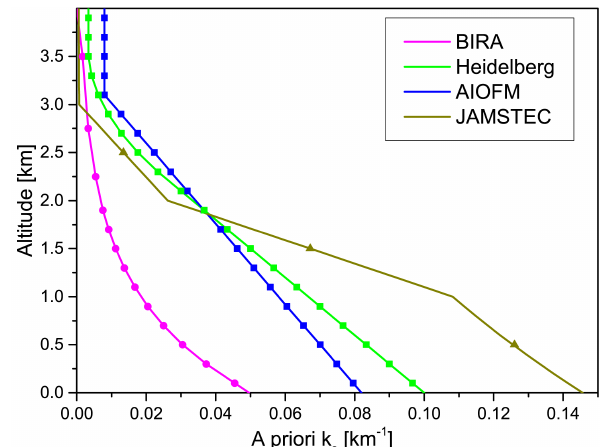
Figure 1. A priori profiles for the BIRA, Heidelberg, AIOFM, and JAMSTEC retrievals. The symbols indicate the centre of each re- trieval layer. The BIRA, Heidelberg, and AIOFM algorithms use a 200m vertical grid with constant extinction in each layer, and JAM- STEC a 1km grid with exponentially decreasing extinction in each